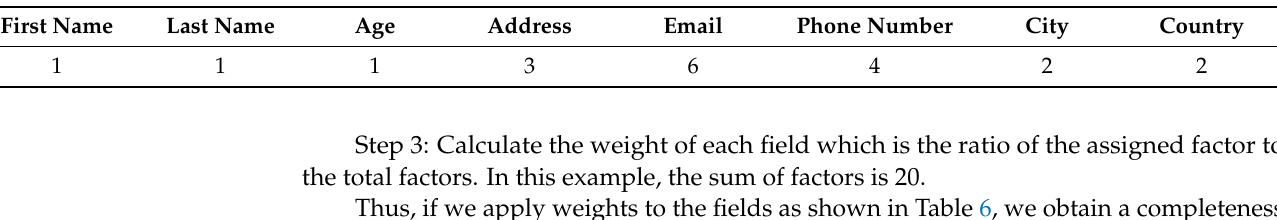
Table 5. Field’s factors.